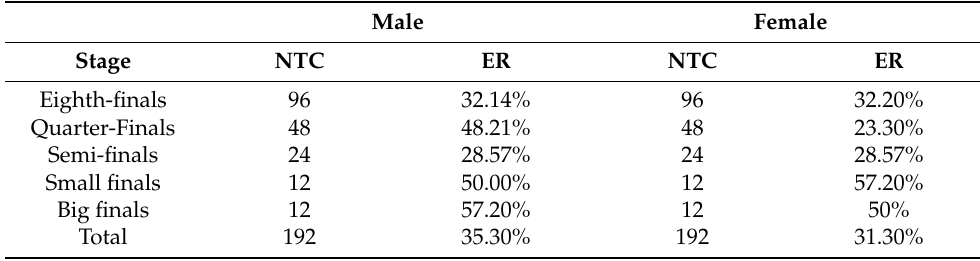
Table 4. A comparison between error rates in different competition stages for male and female athletes analyzed in the finals of 6 different competitions.